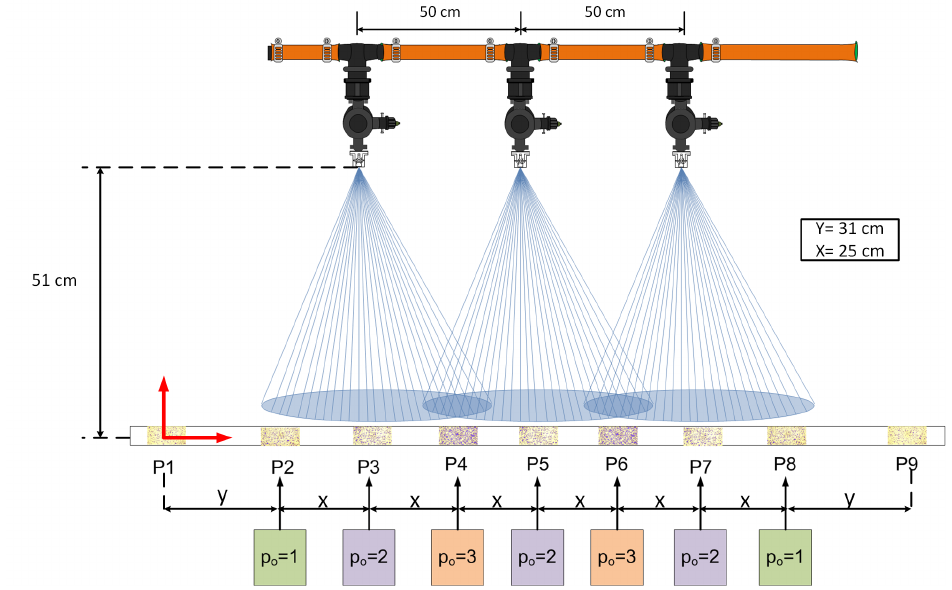
Figure 7. Labels of the critical points in the spray boom.